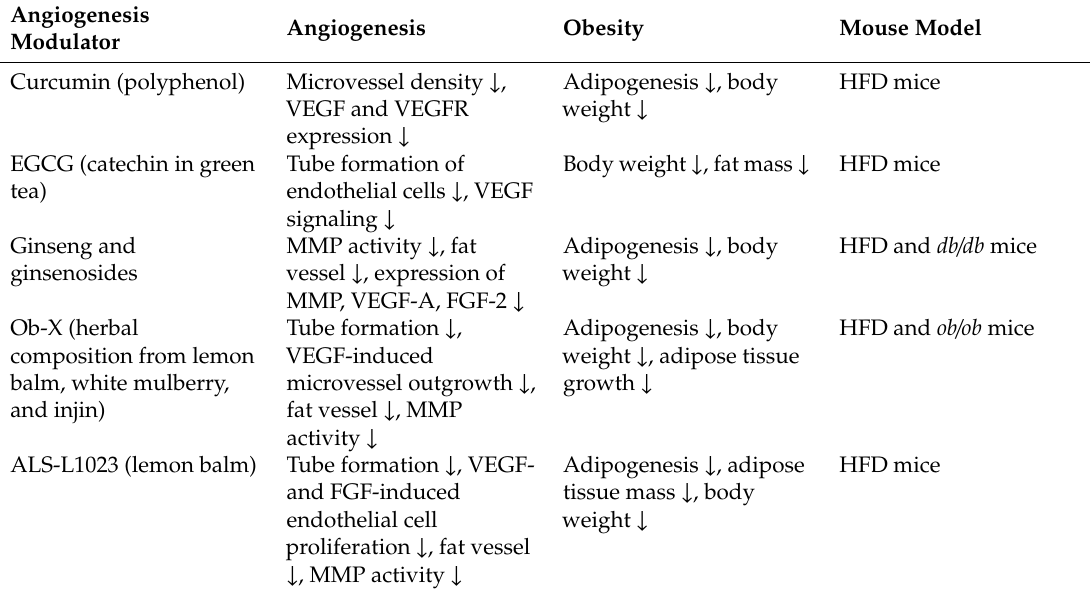
Table 4. E ff ects of medicinal herbs on angiogenesis and